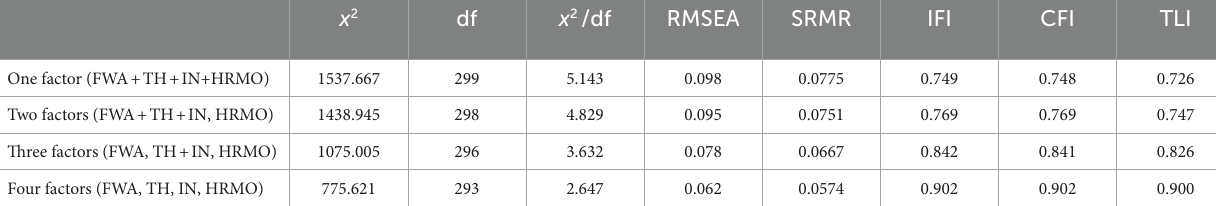
TABLE 3 Results of confirmatory